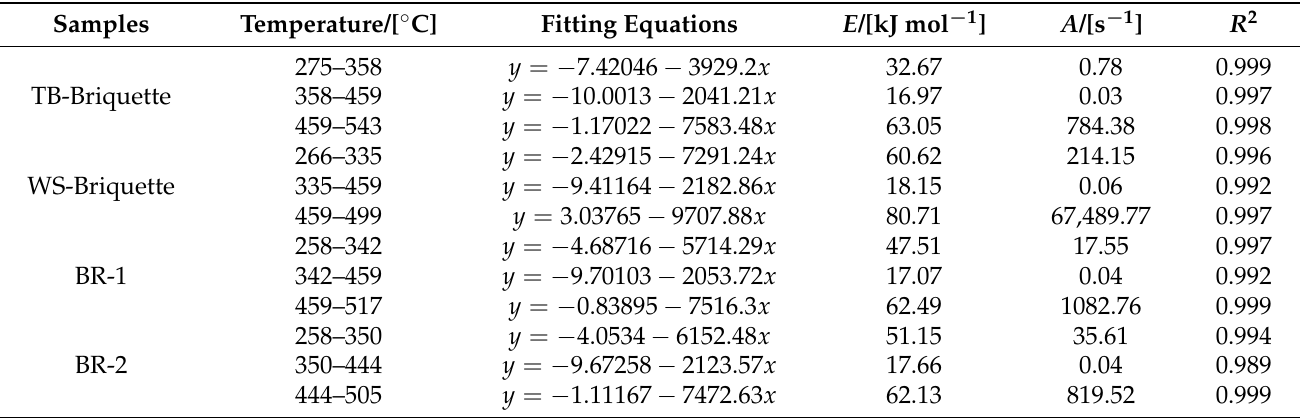
Figure 7. Simulations equations on kinetic analysis by Coats-Redfern method. Table 3. Combustion kinetic parameters of biomass